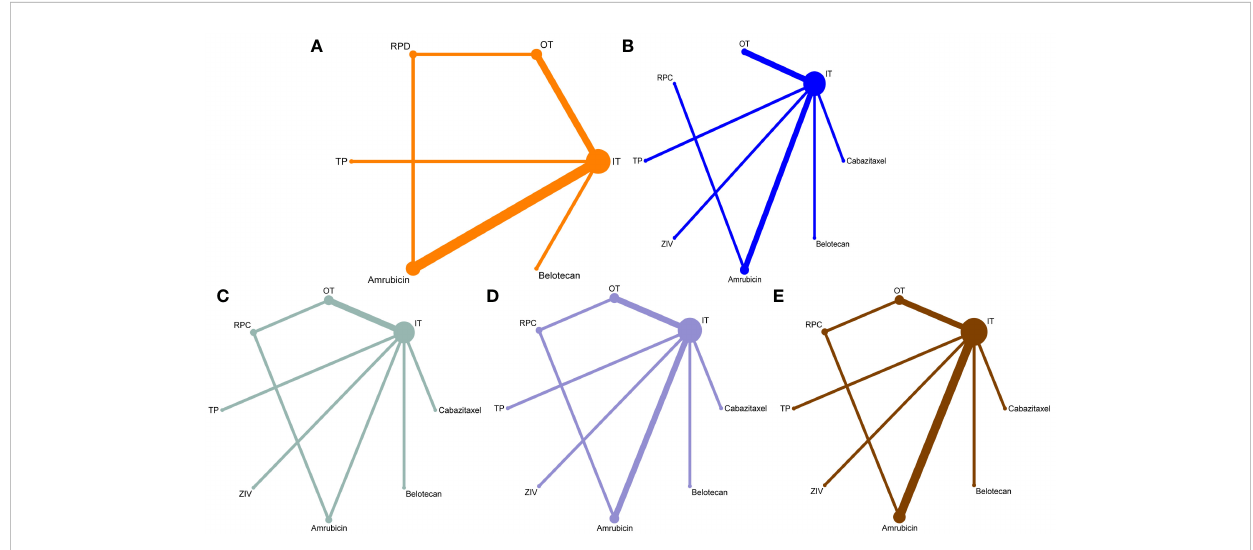
FIGURE 1 Network maps for the comparisons of the second-line treatments for patients with relapsed small-cell lung cancer sensitive to previous platinum- based chemotherapy. (A) for overall response rate, (B) for disease control rate, (C) for progression-free survival, (D) for overall survival rate, and (E) for hematological complications grade 3 to 5 (including anemia, thrombocytopenia, and neutropenia). The width of each line represents the number of connections between the two studies, and the size of the dots indicates the frequency of included regimens appeared in the